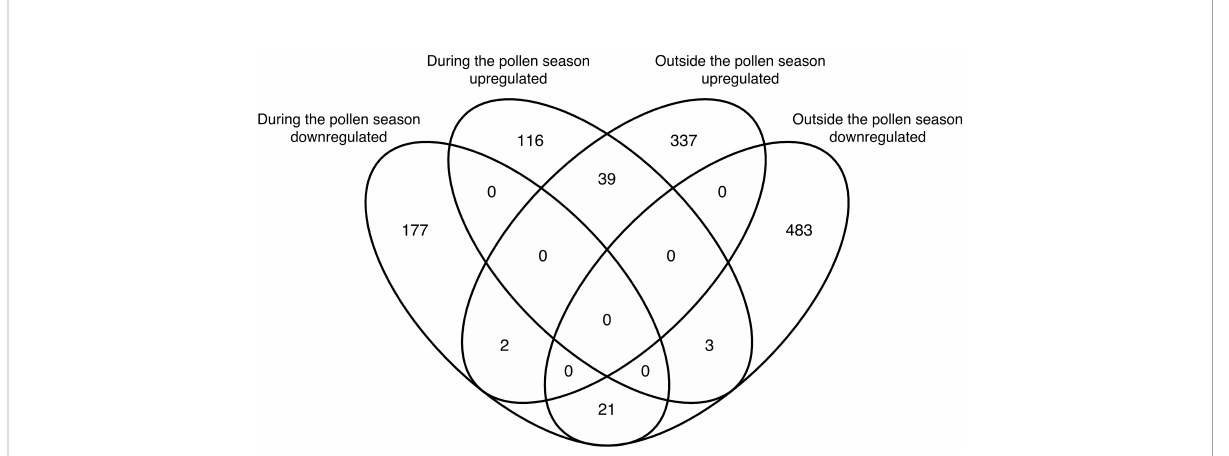
FIGURE 4 Venn diagram showing the intersection of DEGs between the AR-asthma group and AR group during the pollen season and outside the pollen season. AR, allergic rhinitis; DEGs, differentially expressed